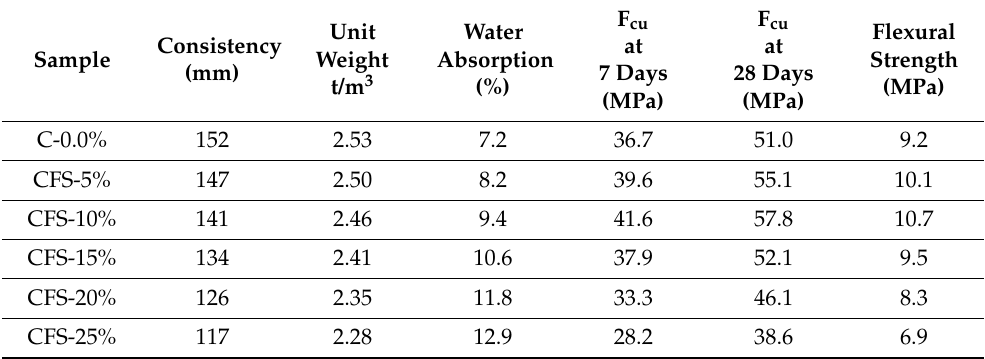
Table 4. Properties of the CFS